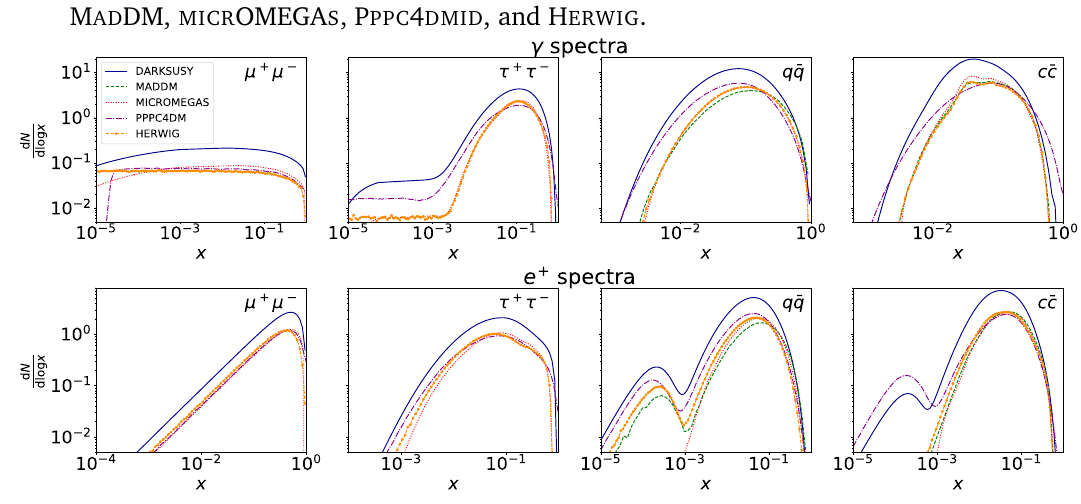
Figure 1: Photon and positron spectra dN / d log x with x = E from the different hard annihilation channels. We show results from D ARK S USY ,